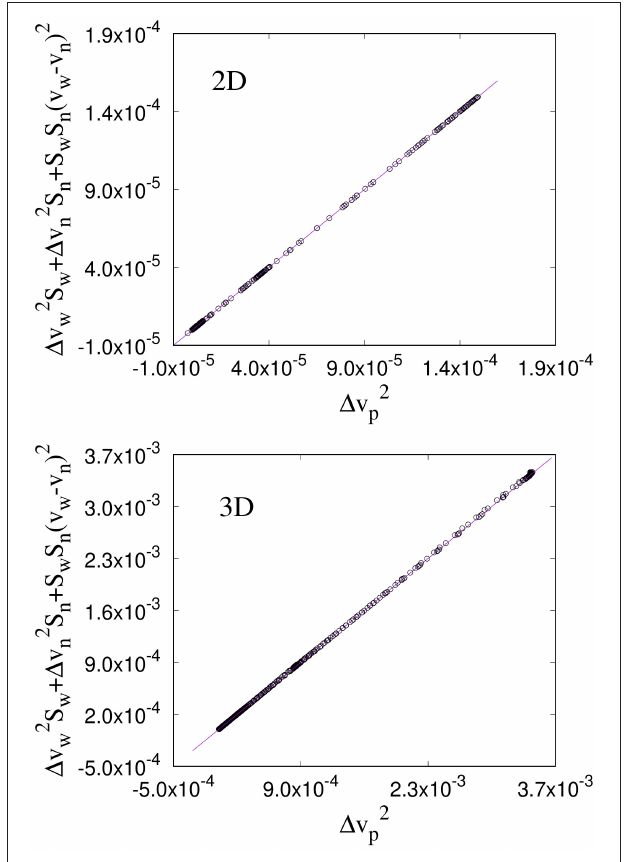
FIGURE 3 | Numerical verification of Equation (74) between the fluctuations in the seepage velocities. 1 v 2 p has a unit mm 2 /s.